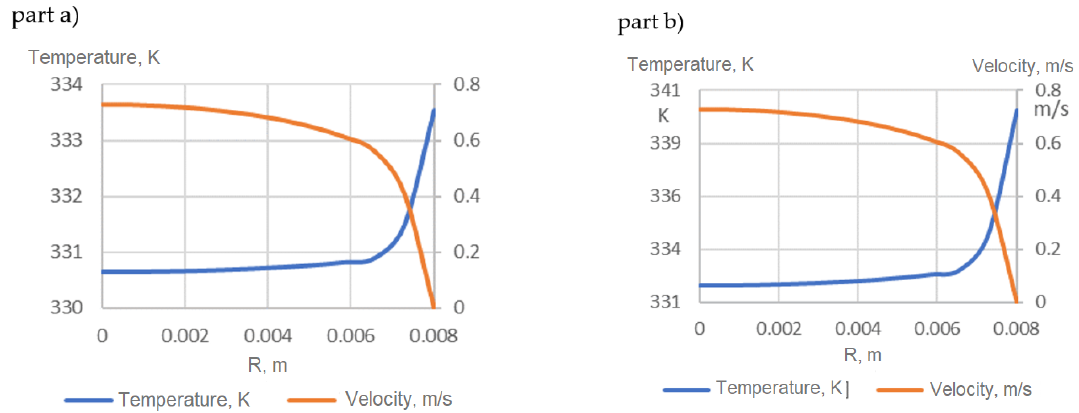
Figure 8. Velocity and temperature profiles in fully developed flow ( a ) constant HF ( b ) constant temperature of